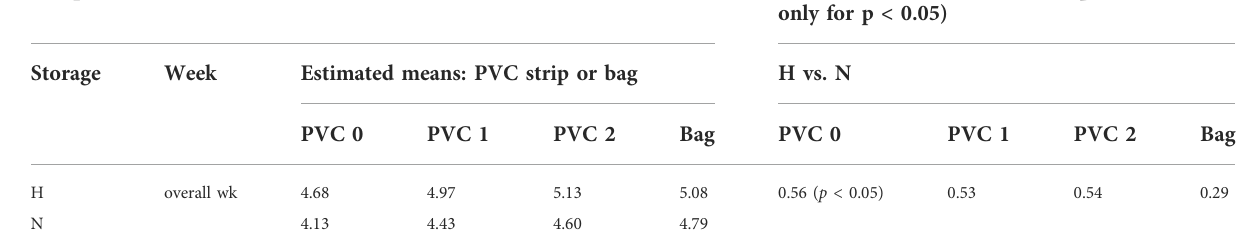
B. Weekly estimated differences for PVC levels (H vs.